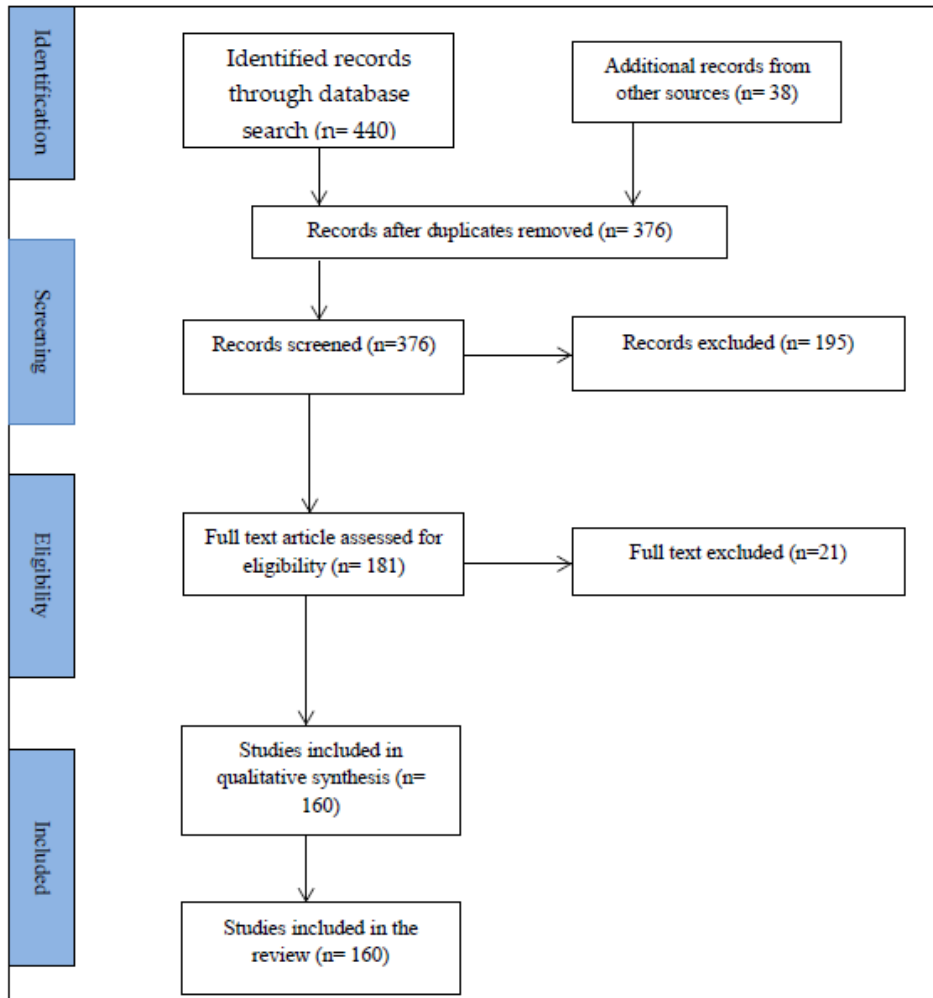
Figure 1. PRISMA flow diagram of the articles obtained, selected and included in the review.